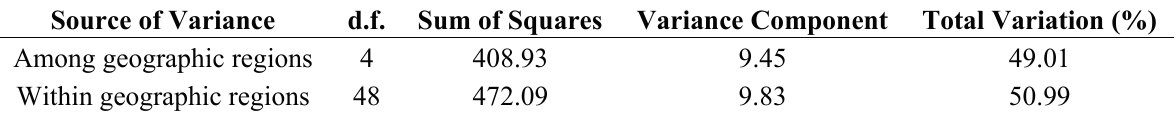
Table 4. Analysis of molecular variance (AMOVA) of five geographic regions .